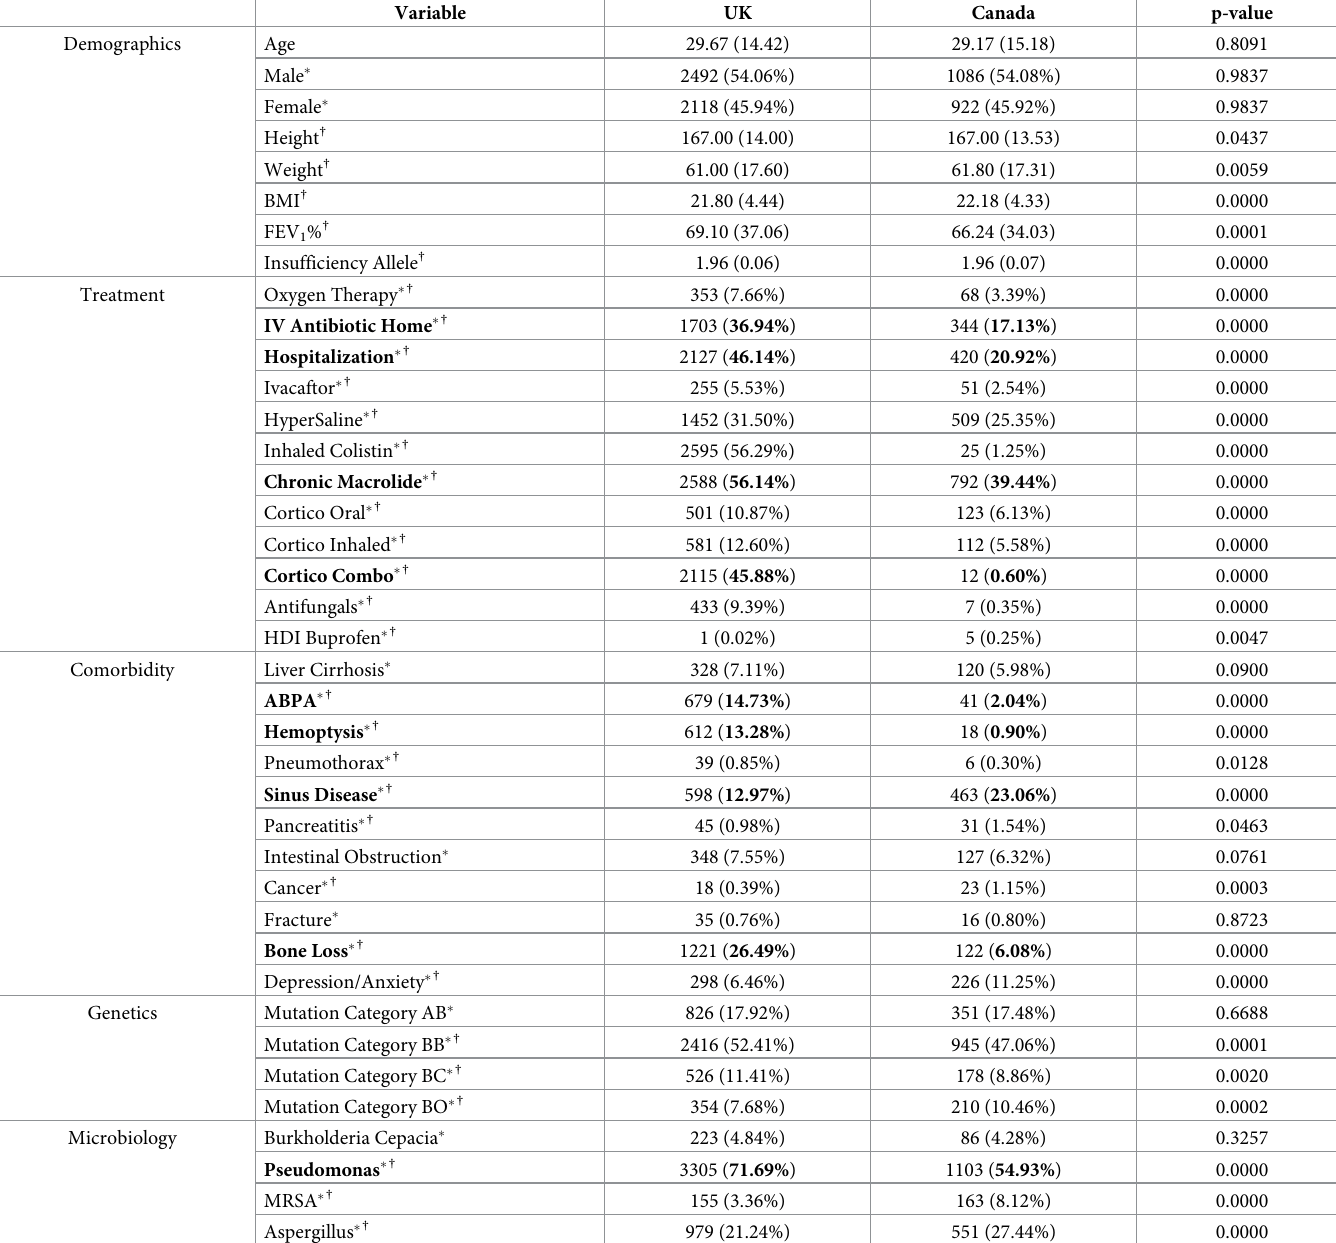
Table 2. Major characteristics of the studied UK and Canadian CF cohorts in 2014. Binary variables were marked by � with occurrence and incidence rate reported. Continuous variables were reported with median value and IQR. Variables with different mean values in these two populations were identified via two-sample t-test under the p-value of 0.05 and were marked with † . Binary variables with a gap over 10% in incidence rate between the two populations were highlighted in